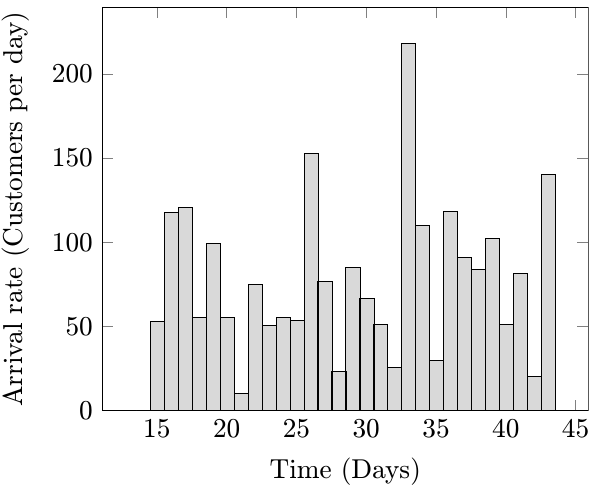
Figure 2: A snapshot of the customer arrival rate for ATM i shows the time-varying nature of the